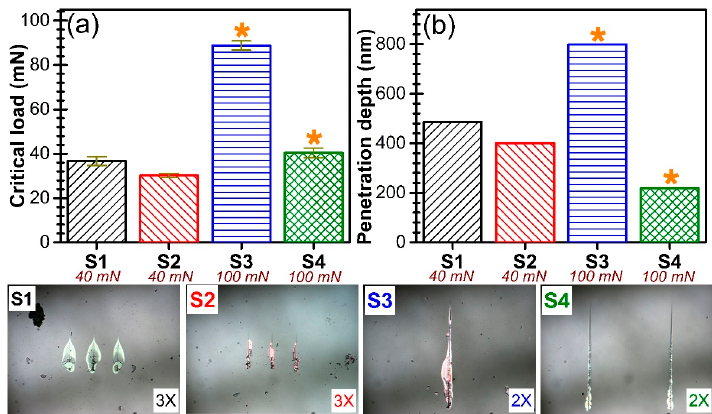
Figure 10. Graphical representation of the ( a ) critical load values at which destructive events occurred and ( b ) the corresponding penetration depth values. Microscopic images of the scratches are enclosed.